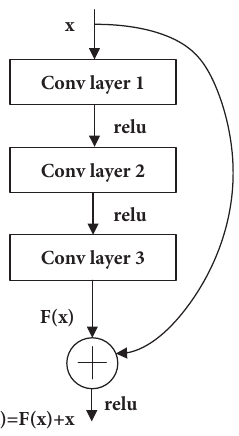
Figure 1: Shortcut connection structure in